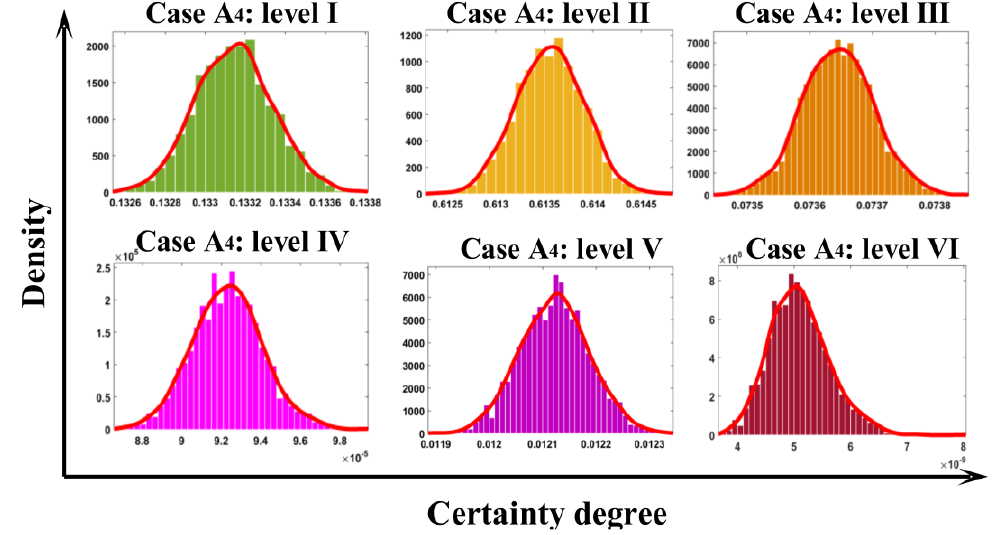
Figure 10. Distributional patterns of certainty degrees in each level of Case A 4 .